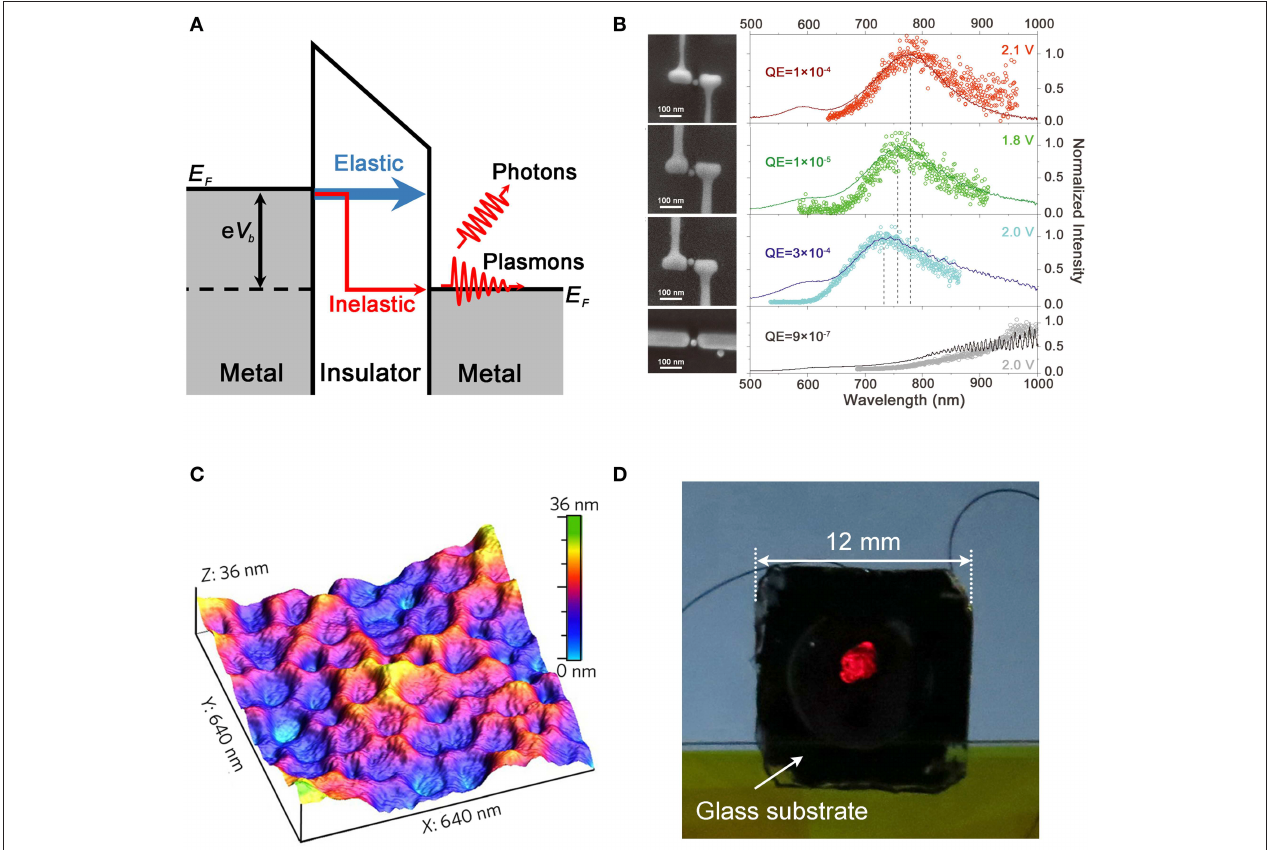
FIGURE 1 | (A) Schematic diagram of generation of surface plasmons and photons through IET. (B) Electroluminescence (data points) and scattering spectra (solid lines) for antennas with various geometries and a micrometer-long non-resonant wire, together with the corresponding SEM images. (C) Atomic force microscopy image of a gold nanorod array with the dips marking the positions of Au few nanometers below the surface of an Al 2 O 3 matrix. (D) Photograph of an Au nanorod array electrically driven at a bias of 2.5V. (B) is reprinted with permission from Ref. [28]. Copyright © 2015, Springer Nature. (C,D) are reprinted with permission from